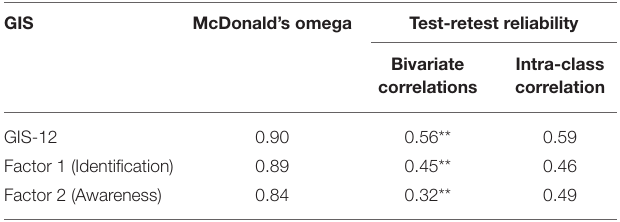
TABLE 6 | McDonald’s omega and test-retest reliability of the GIS-12 and its factors.